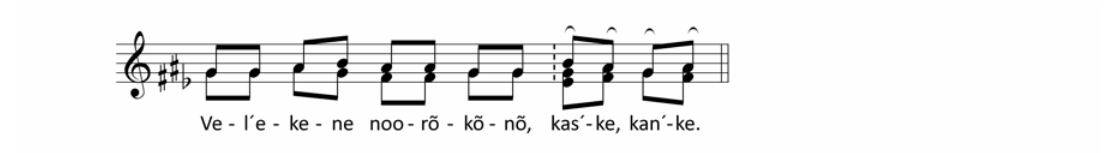
Figure 1: 8-syllable/position verses with stresses in the uneven verse positions, all the stress groups have two positions (2+2+2+2 structure). The choir of Anne Vabarna, ’Dear brother, dear young